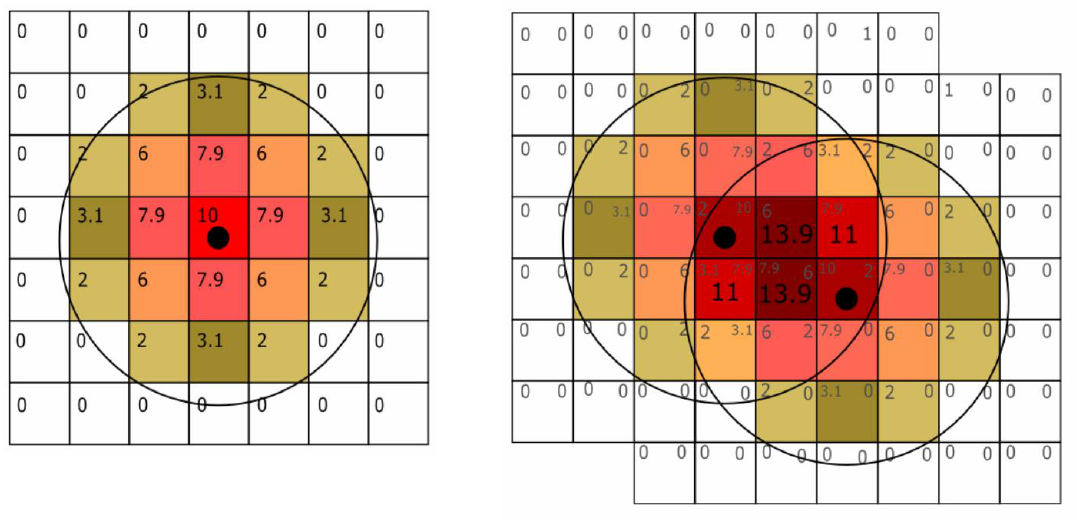
Figure 2: Example of a kernel density, calculated with the Gaussian distribution of the value 10 on the surrounding meshes (search radius, R = 3 meshes), (a) for a single point, (b) for two points.